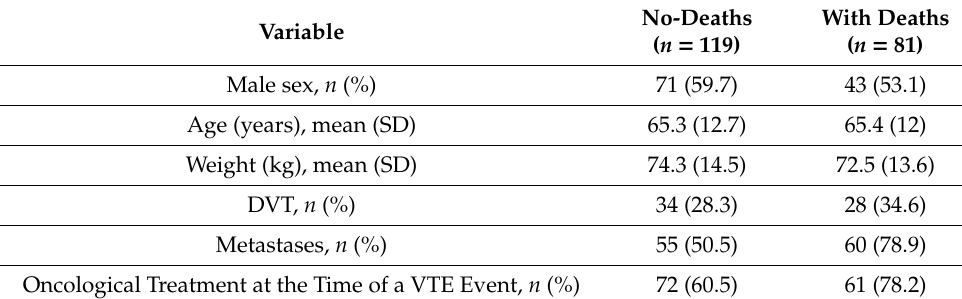
Table 2. Baseline patient characteristics in the no-death vs. death